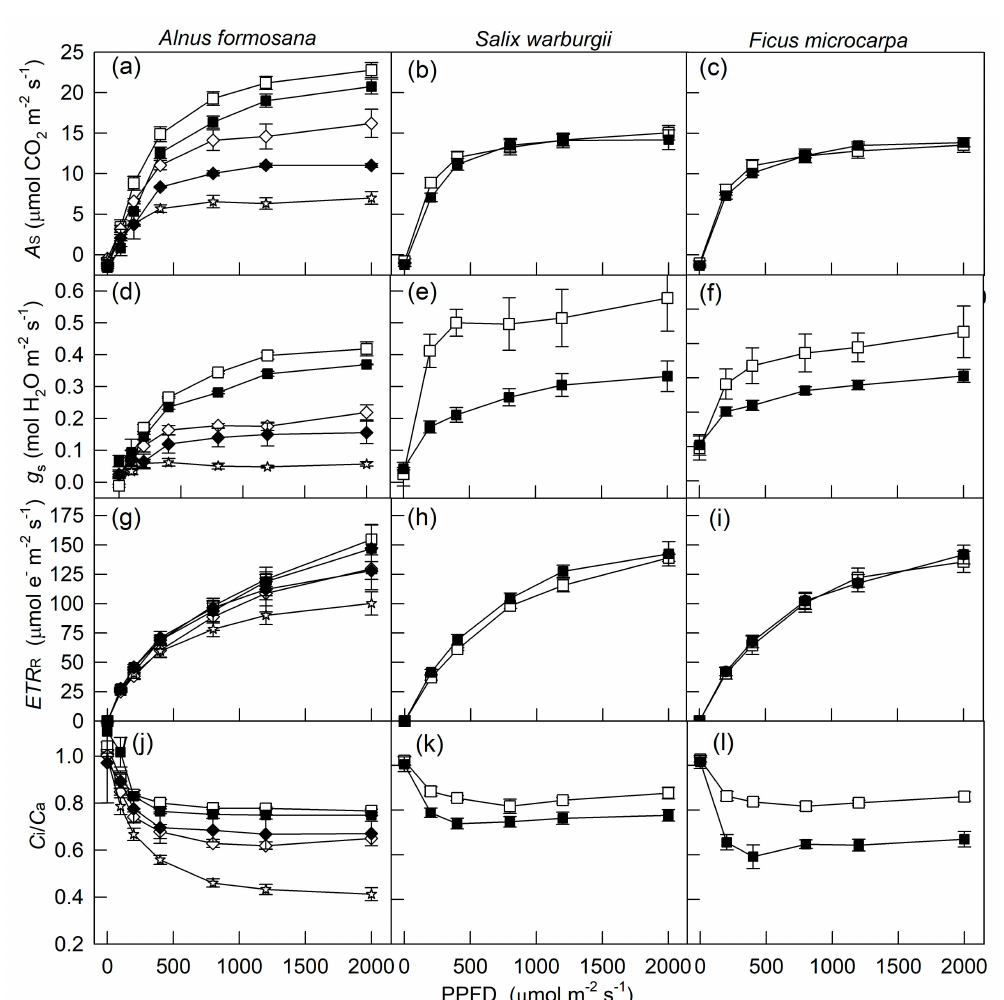
Figure 1. Light-response curves of A s ( a – c ), g s ( d – f ), ETR R ( g – i ), and C i / C a ( j – l ) for three tree species measured at 25 ◦ C and 80% (open symbols) and 40% (closed symbols) relative humidity. A S and g s indicate the net photosynthetic rate and stomatal conductance, respectively, obtained from steady-state light response; ETR R indicates electron transport rate obtained from rapid light response; C i and C a indicate intercellular and atmospheric CO 2 concentration, respectively, obtained from steady-state light response. Squares, diamonds, and stars g s indicate measured under well-watered conditions, mild and severe drought, respectively. Data are mean ±